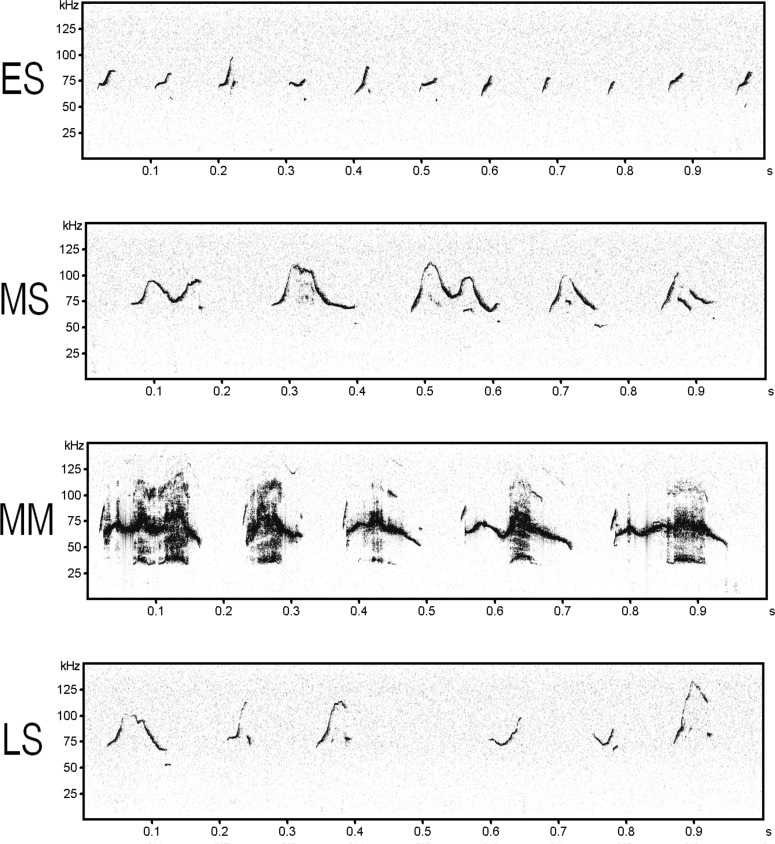
Spectrogram of ultrasonic vocalizations during the ES (A), MS (B), MM (C), and LS (D).